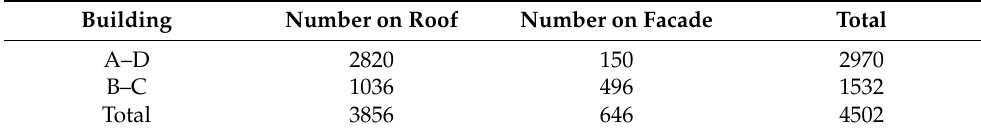
Table 2. Quantity of PV panels and power.